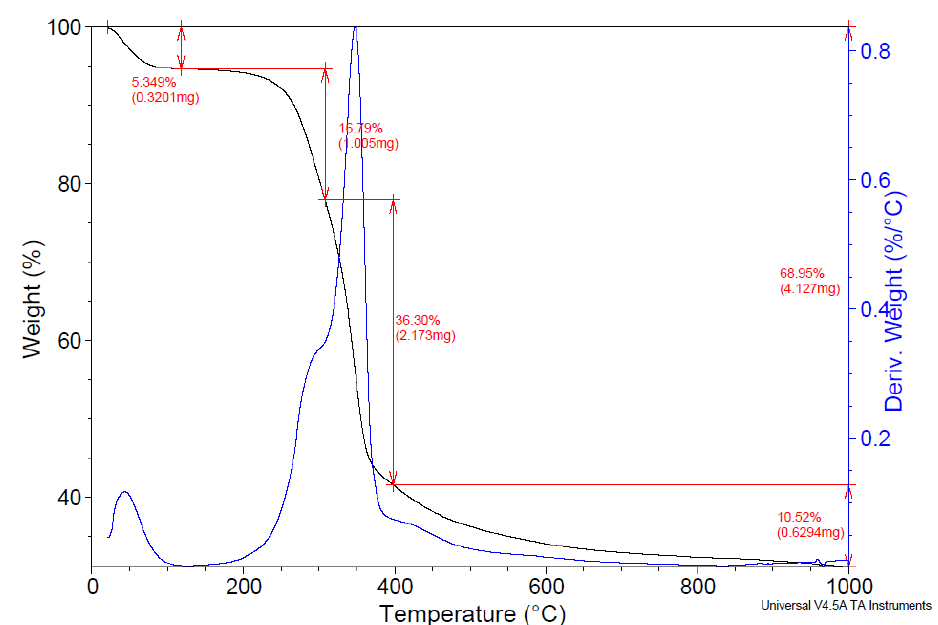
Figure 4. TGA and DTG curves for rice husk.